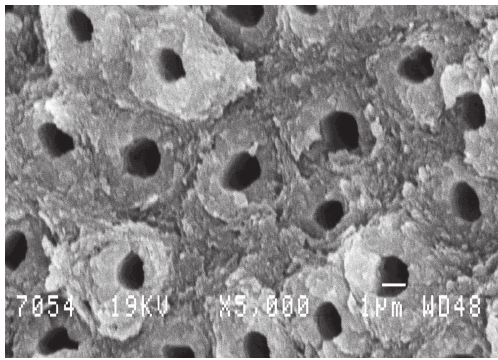
Figure 4: View of the dentine conditioned by Er:YAG laser (group ML), the Er:YAG laser had removed the smear layer. The tubules are totally opened. The Er:YAG laser produced a selective and preferential ablation of intertubular dentine, while the peritubular dentine (higher mineralization) was less ablated. Magnification: 5000x. Scale bar = 1 µ